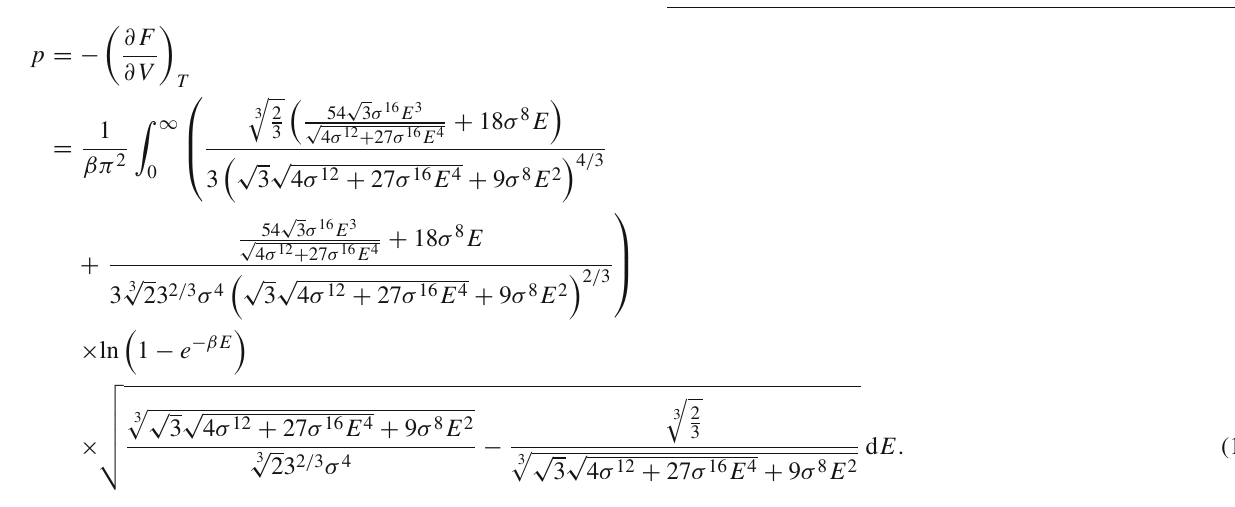
which, immediately,